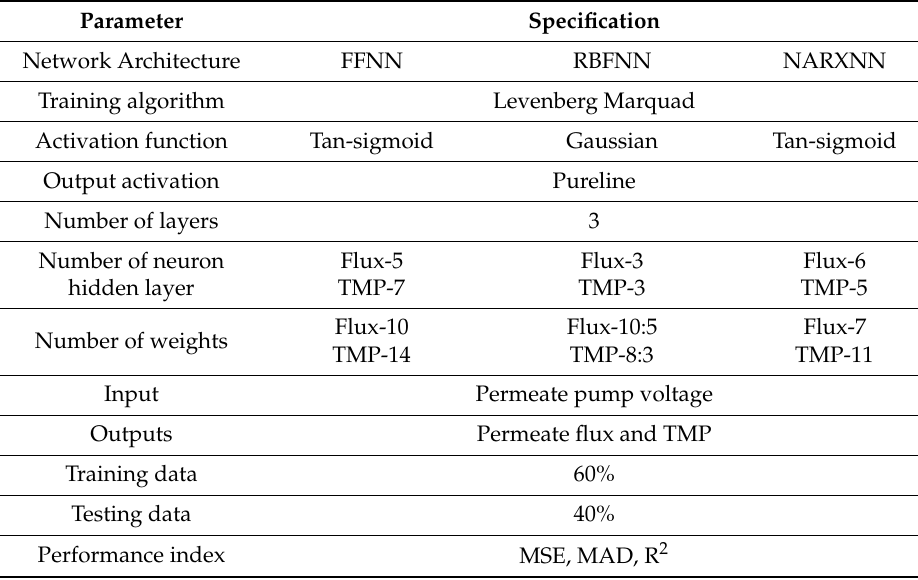
Table 1. Activation function.